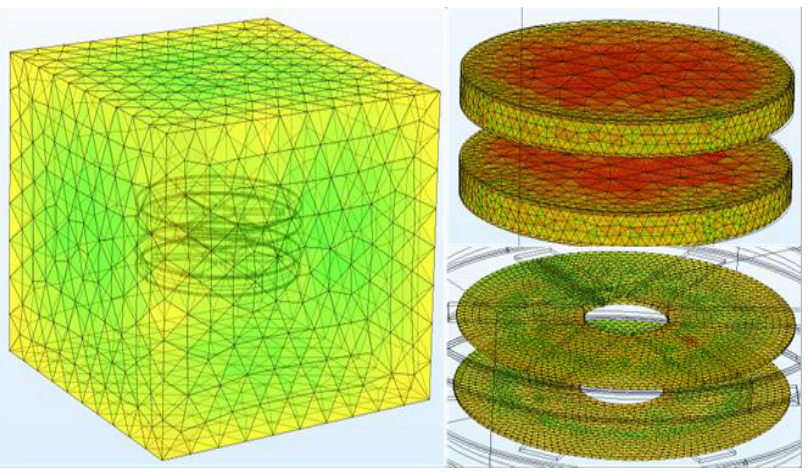
Figure 5. Meshing result . Figure 5. Meshing